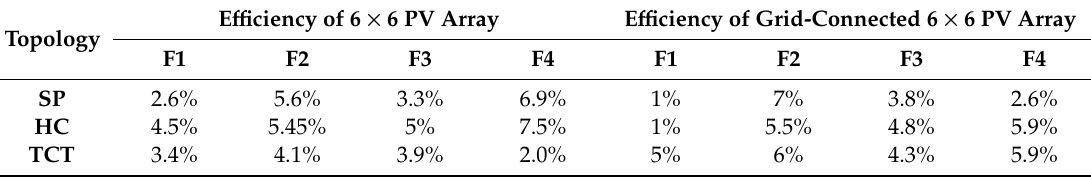
Table 12. E ffi ciency comparison of thin film with monocrystalline PV in fault scenarios (FS). E ffi ciency of 6 × 6 PV Array E ffi ciency of Grid-Connected 6 × 6 PV Array Topology F1 F2 F3 F4 F1 F2 F3 F4 SP 2.6%